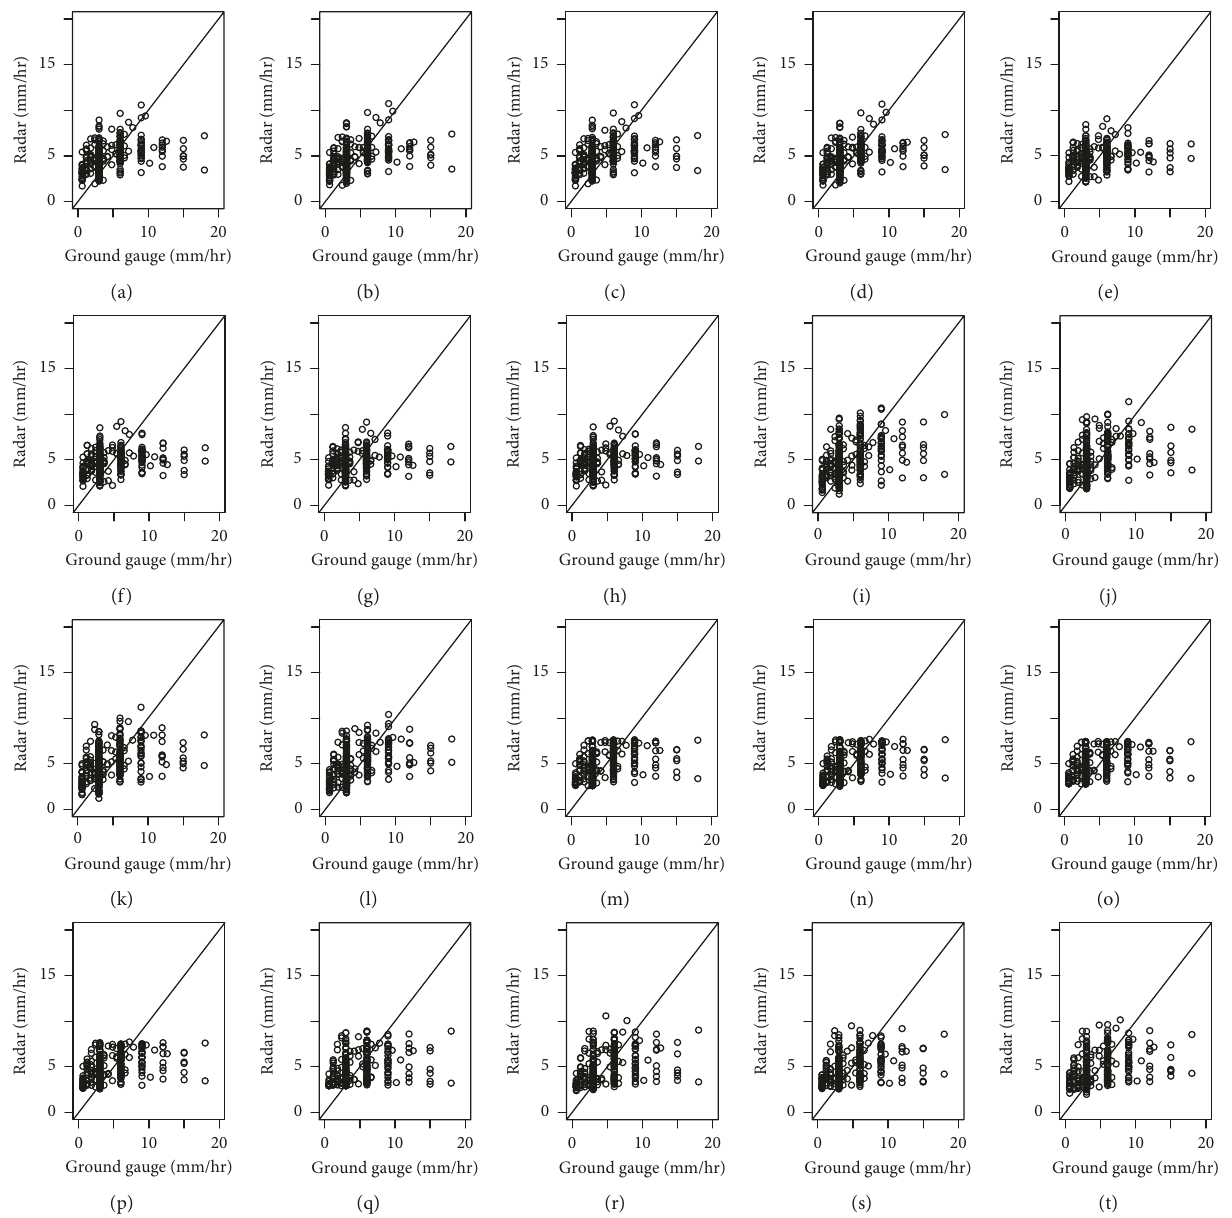
Figure 6: Plots of rainfall rate estimations versus observations of tested models for precipitation event #4. (a) ZR1-L1 (RMSE: 2.88, R : 0.42). (b) ZR2-L1 (RMSE: 2.86, R : 0.43). (c) ZR3-L1 (RMSE: 2.88, R : 0.42). (d) ZR5-L1 (RMSE: 2.86, R : 0.43). (e) ZR1-L0 (RMSE: 3.05, R : 0.27). (f) ZR2-L0 (RMSE: 3.02, R : 0.3). (g) ZR3-L0 (RMSE: 3.05, R : 0.28). (h) ZR5-L0 (RMSE: 3.02, R : 0.3). (i) RF1 (RMSE: 2.93, R : 0.43). (j) RF2 (RMSE: 2.97, R : 0.42). (k) RF3 (RMSE: 2.89, R : 0.45). (l) RF5 (RMSE: 2.85, R : 0.46). (m) GBM1 (RMSE: 2.89, R : 0.42). (n) GBM2 (RMSE: 2.86, R : 0.42). (o) GBM3 (RMSE: 2.88, R : 0.42). (p) GBM5 (RMSE: 2.86, R : 0.43). (q) ELM1 (RMSE: 2.91, R : 0.39). (r) ELM2 (RMSE: 2.9, R : 0.41). (s) ELM3 (RMSE: 2.9, R : 0.4). (t) ELM5 (RMSE: 2.89, R :